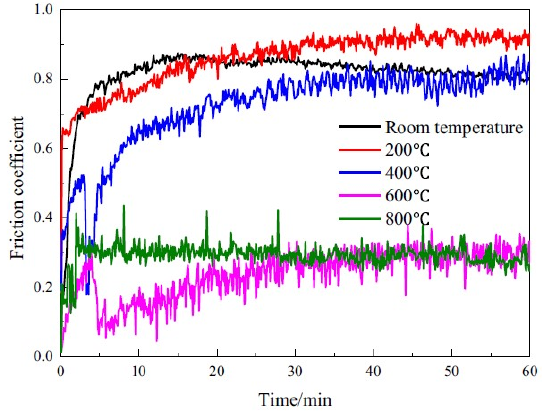
Figure 10. Friction coefficient of the FeNiCoAlCu HEA coating at different temperatures [86].